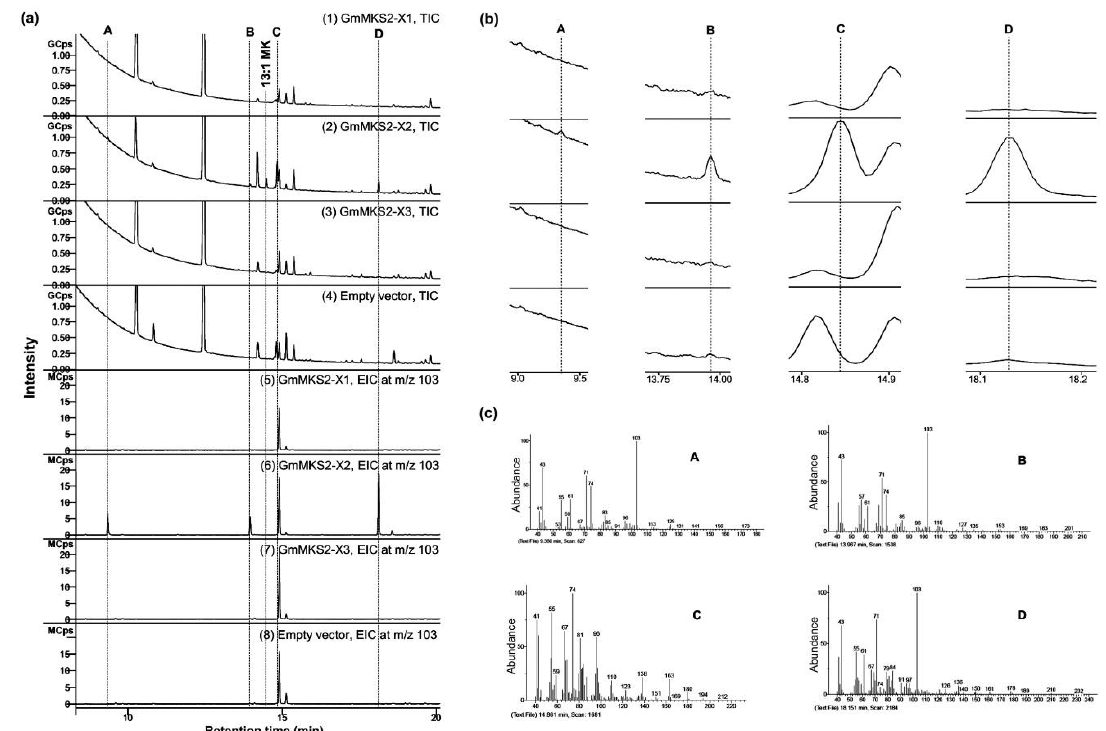
Figure 3. Analysis by GC of methyl esters obtained from fatty acids secreted into the culture by E. coli